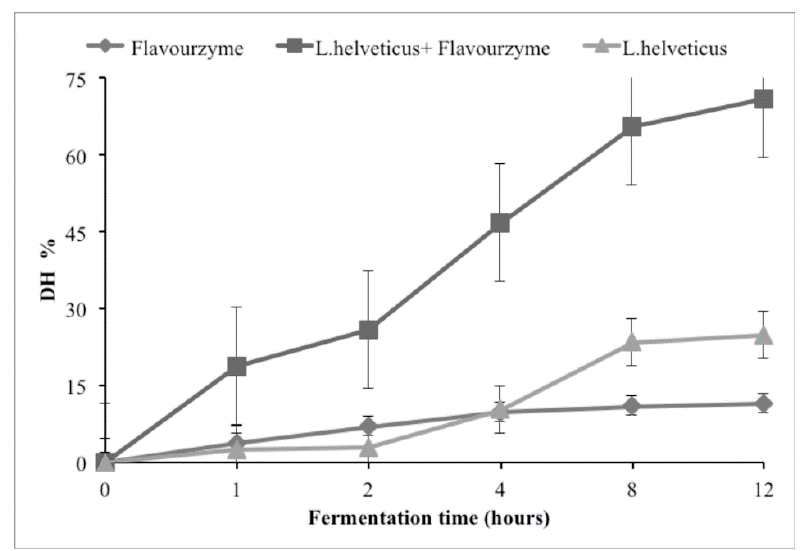
Figure 2. Degree of hydrolysis (DH%) in fermented skim milk generated following the combination of L. helveticus 881315 and Flavourzyme ® (square), L. helveticus 881315 alone (triangle), and Flavourzyme ® alone (diamond) at 37 °C for 0–12 h fermentation. Values are mean ± SEM of three determinations for DH values.